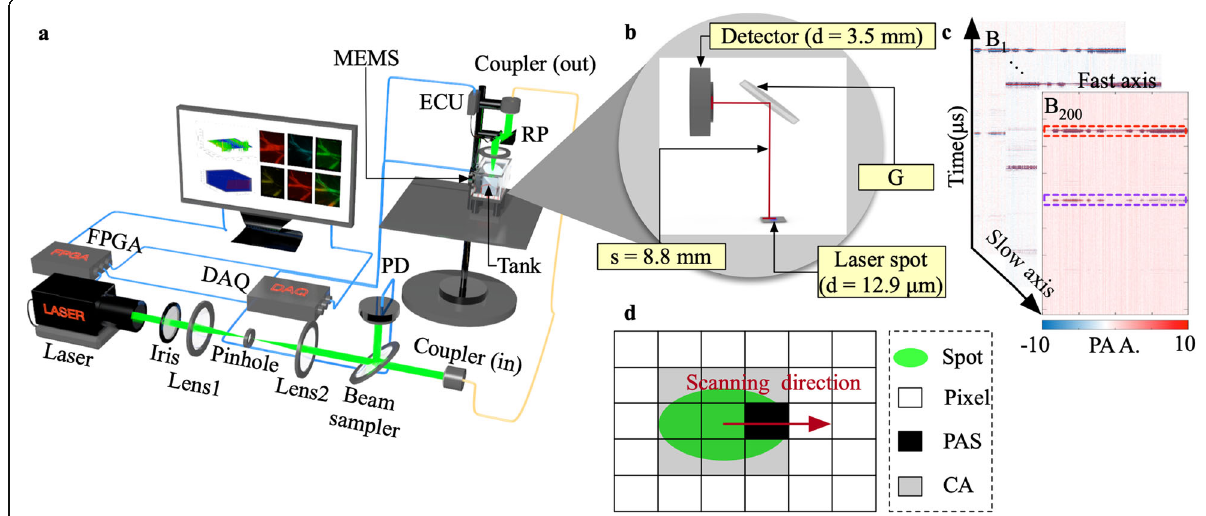
Fig. 1 An overview of MEMS-based photoacoustic microscopy system. a : Schematic of the MOR-PAM; b : Zoomed-in views of the ultrasonic sensor; c : B-Scan images associated with the acquired PA matrix, the PA signals in the red dashed line, and PA signals in the purple dashed line are utilized for reconstruction; d : Projection of the laser spot in MAP image. FPGA: Field programmable gate array; DAQ: Data acquisition unit; MEMS: Micro-electromechanical systems; PD: Photodiode; ECU: Electronic control unit; G: Glass; RP: Reflection prism; s: Scoustic path; PAS: Photoacoustic source; CA: The estimated convolution area; PA A.: Photoacoustic